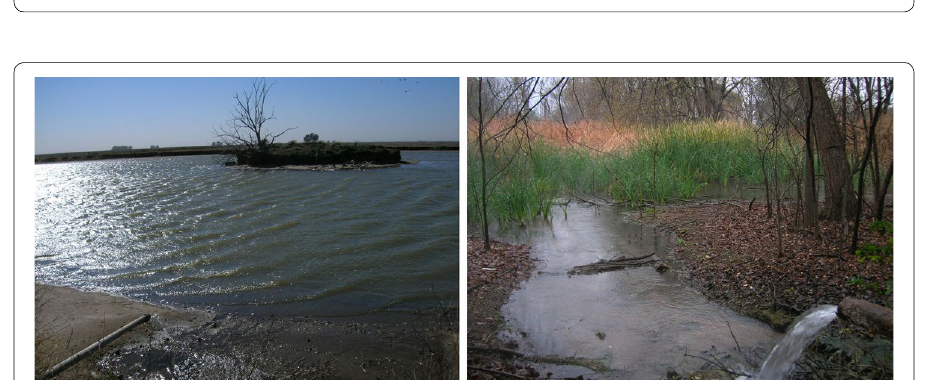
Fig. 2 Artesian wells with high-quality thermal water permanently open for more than 50